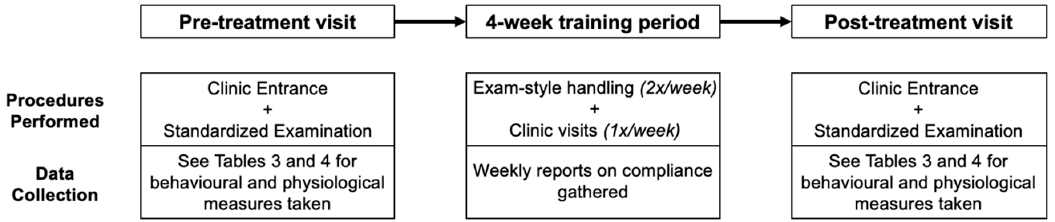
Figure 1. Stages of testing involving pre-treatment visit, four-week training period, and post-treatment visit. Dog owners not allocated to perform training were not given any instructions in between testing and thus were not emailed weekly.